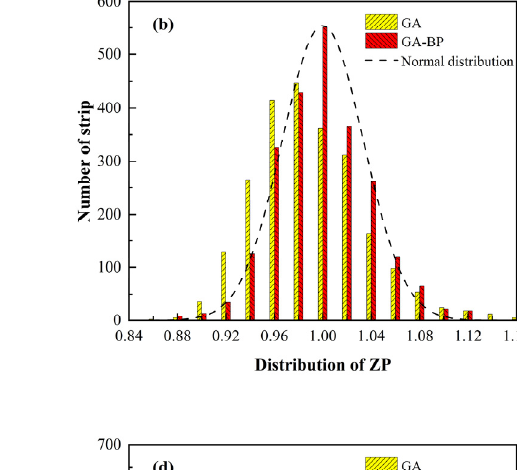
Table 3. Comparison of the rolling force qualification rate,